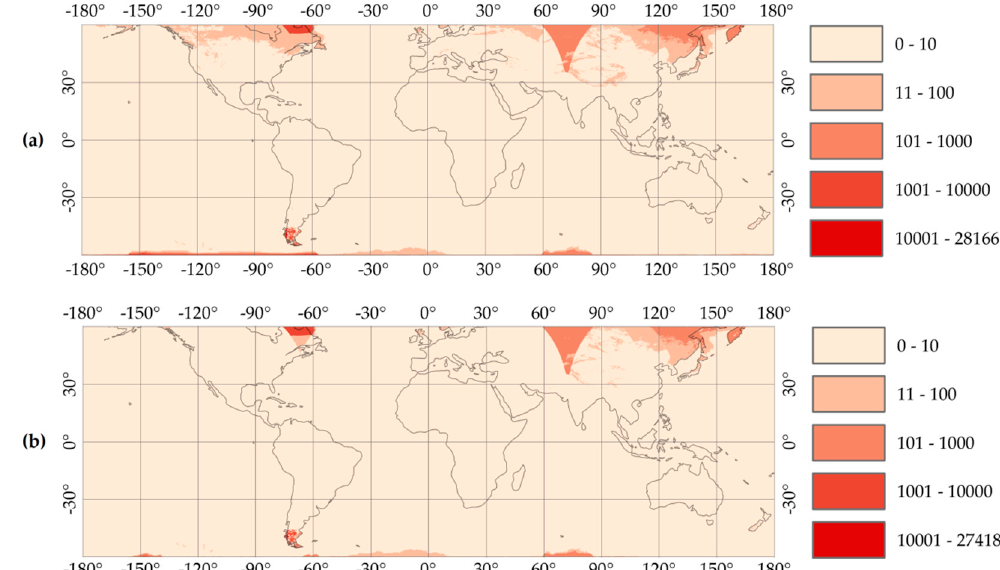
Figure A1. The spatial distribution of no data: The first graph ( a ) is related to the GPM IMERG half-hourly early product, while the second graph ( b ) is related to the GPM IMERG half-hourly late product. The colours refer to the number of half-hourly files in which the measure is absent in the precipitationCal band (the analysis was performed from 12 March 2014 to 30 April 2017 on 55008 files). The reference system is WGS84.